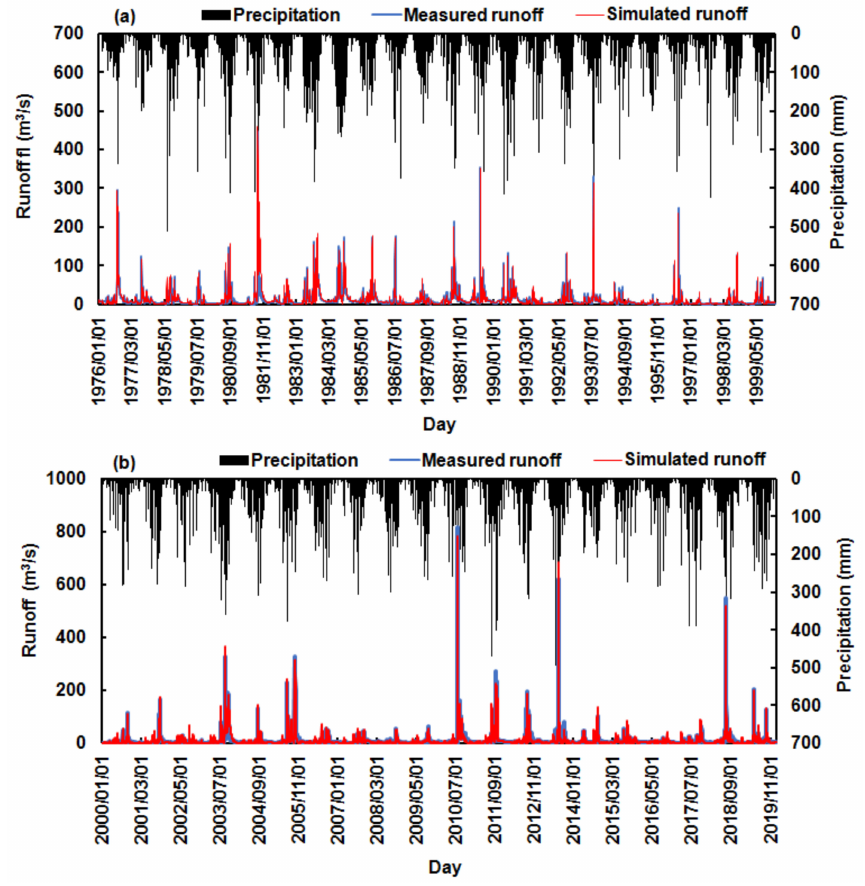
Figure 5. Comparison between daily measured flow and simulated flow in the upper reaches of the Weihe River: ( a ) calibration period and ( b ) verification